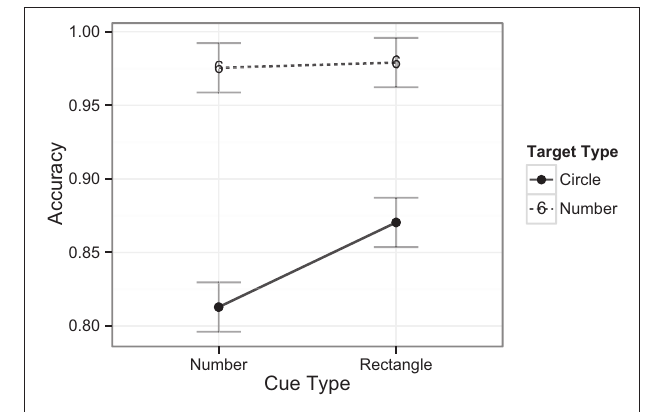
FIGURE 4 | Mean accuracy rates across tasks and cue types. Plotted bars indicate Fisher’s Least Significant Difference (FLSD, similarly for all subsequent